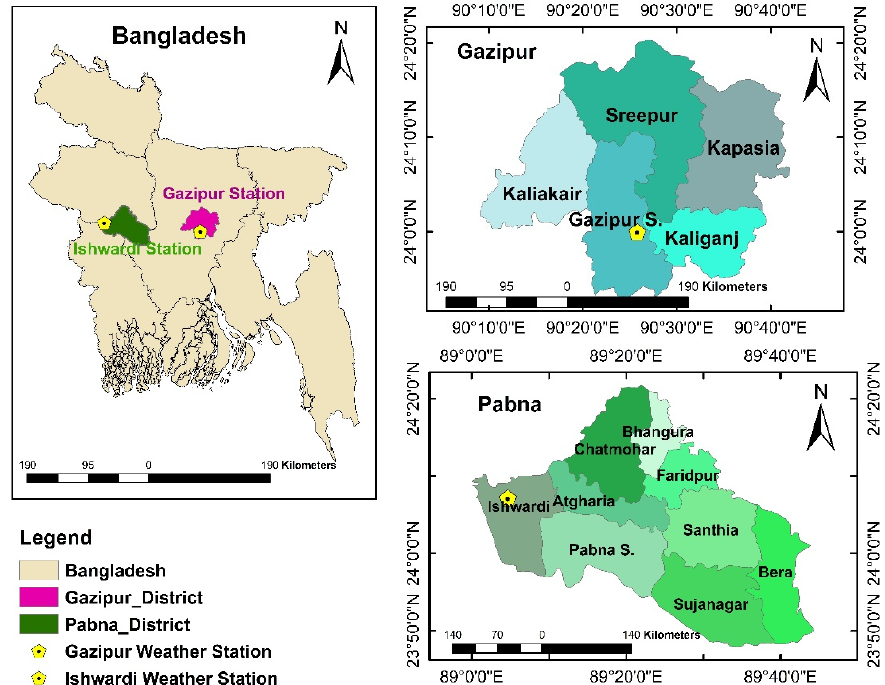
Figure 1. Weather station locations. Table 1. Descriptive statistics of the weather data for the training station (Gazipur Sadar Upazilla).